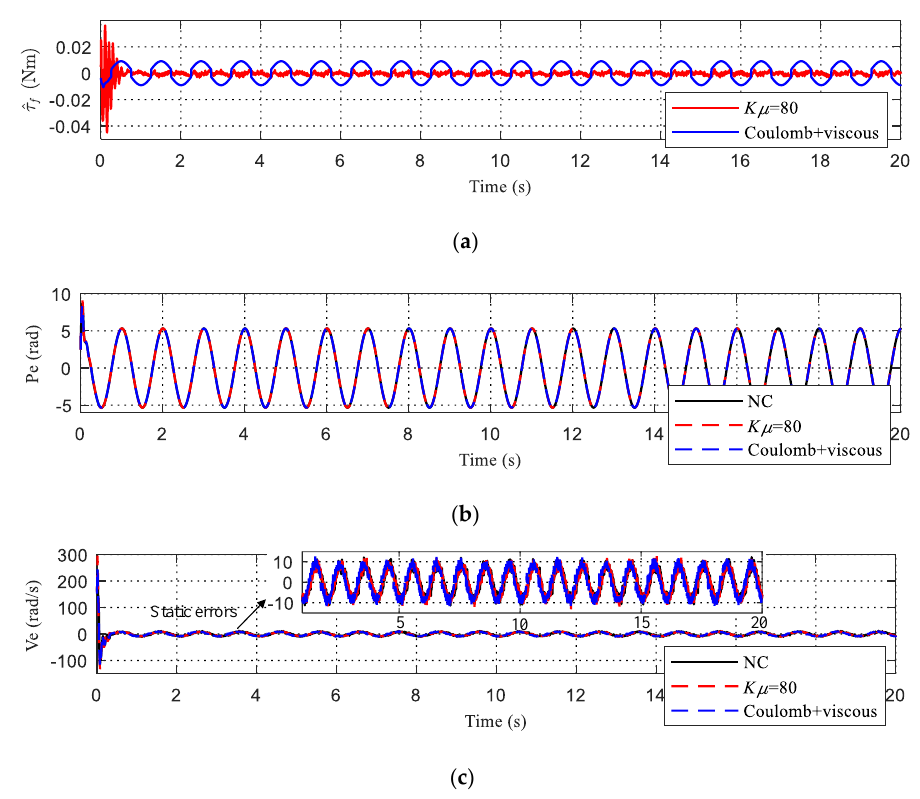
Figure 15. Motor high-velocity with payload experiment results. ( a ) Observed total friction torque (red curve) obtained by the proposed method mapped to the motor-side and estimated motor-side friction torque by the Coulomb and viscous friction model at high velocities. ( b ) Motor position tracking errors at high velocities. ( c ) Motor velocity tracking errors at high velocities. Table 6. Position and velocity tracking error comparison with payload 3 .